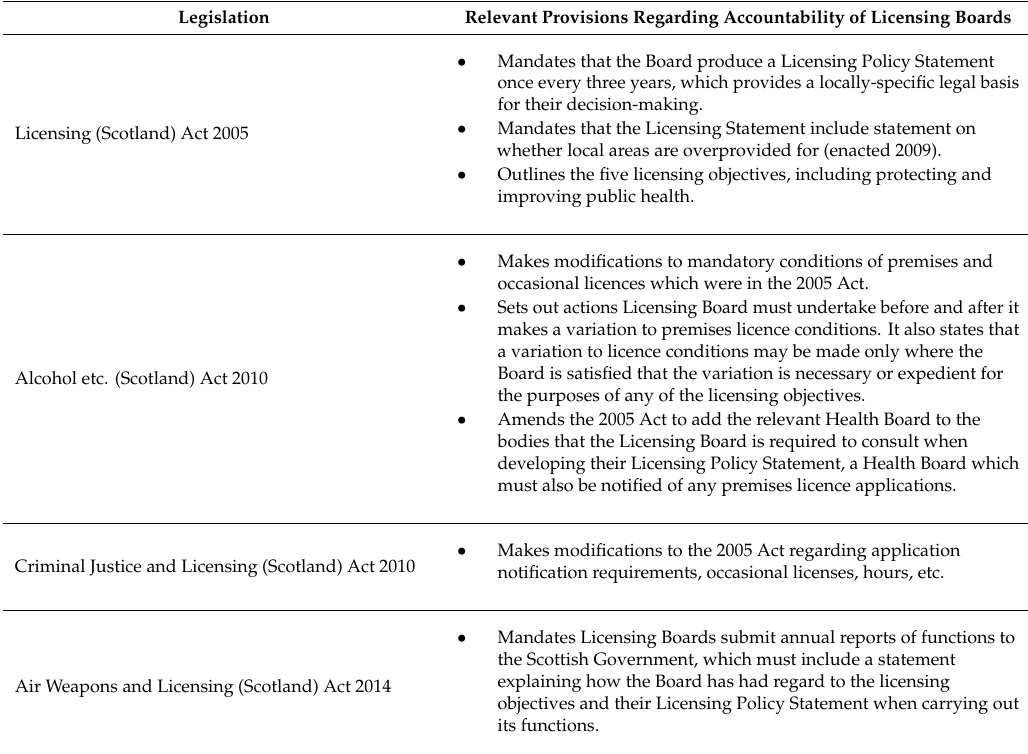
Table 2. Legislative provisions regarding Licensing Board